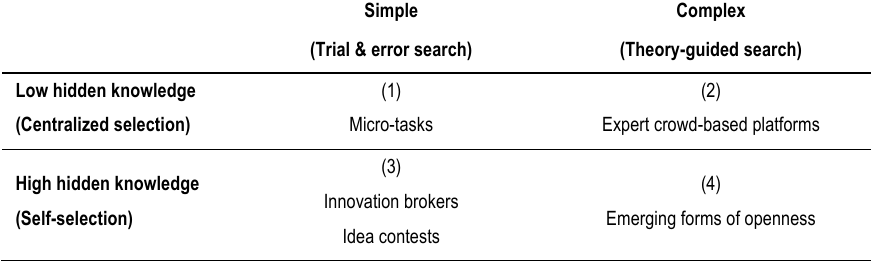
Table 1. Transposing Felin and Zenger’s (2014) taxonomy to the crowd-sourcing context.